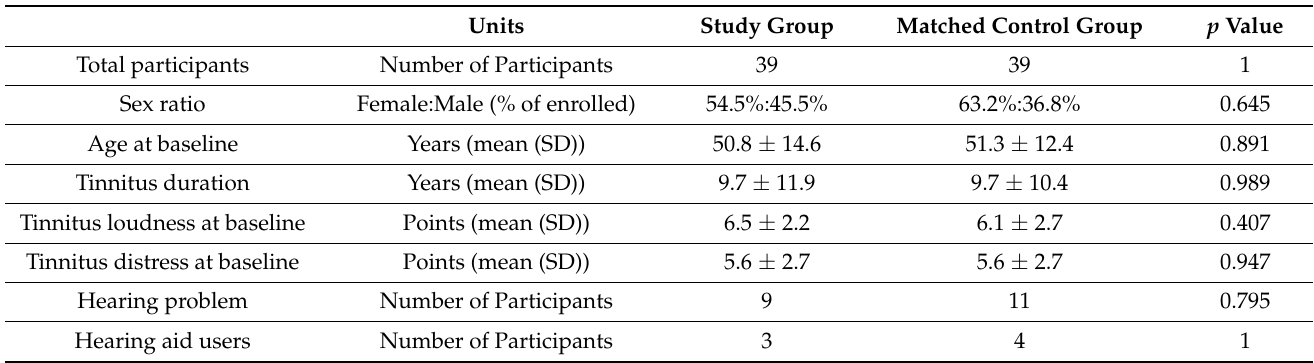
Table 5. Characteristics of the study group and the matched control